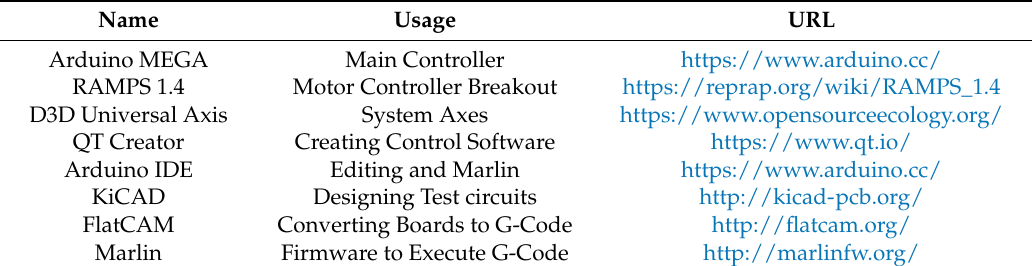
Table 3. All open source tools used in the designed